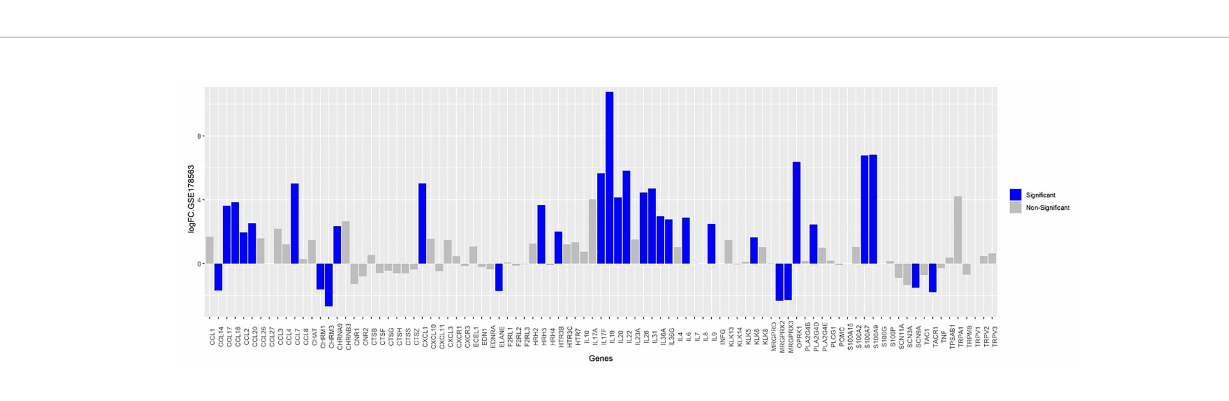
FIGURE 5 | Bar plot of itch-associated genes of GSE178563 (mite-infested human skin